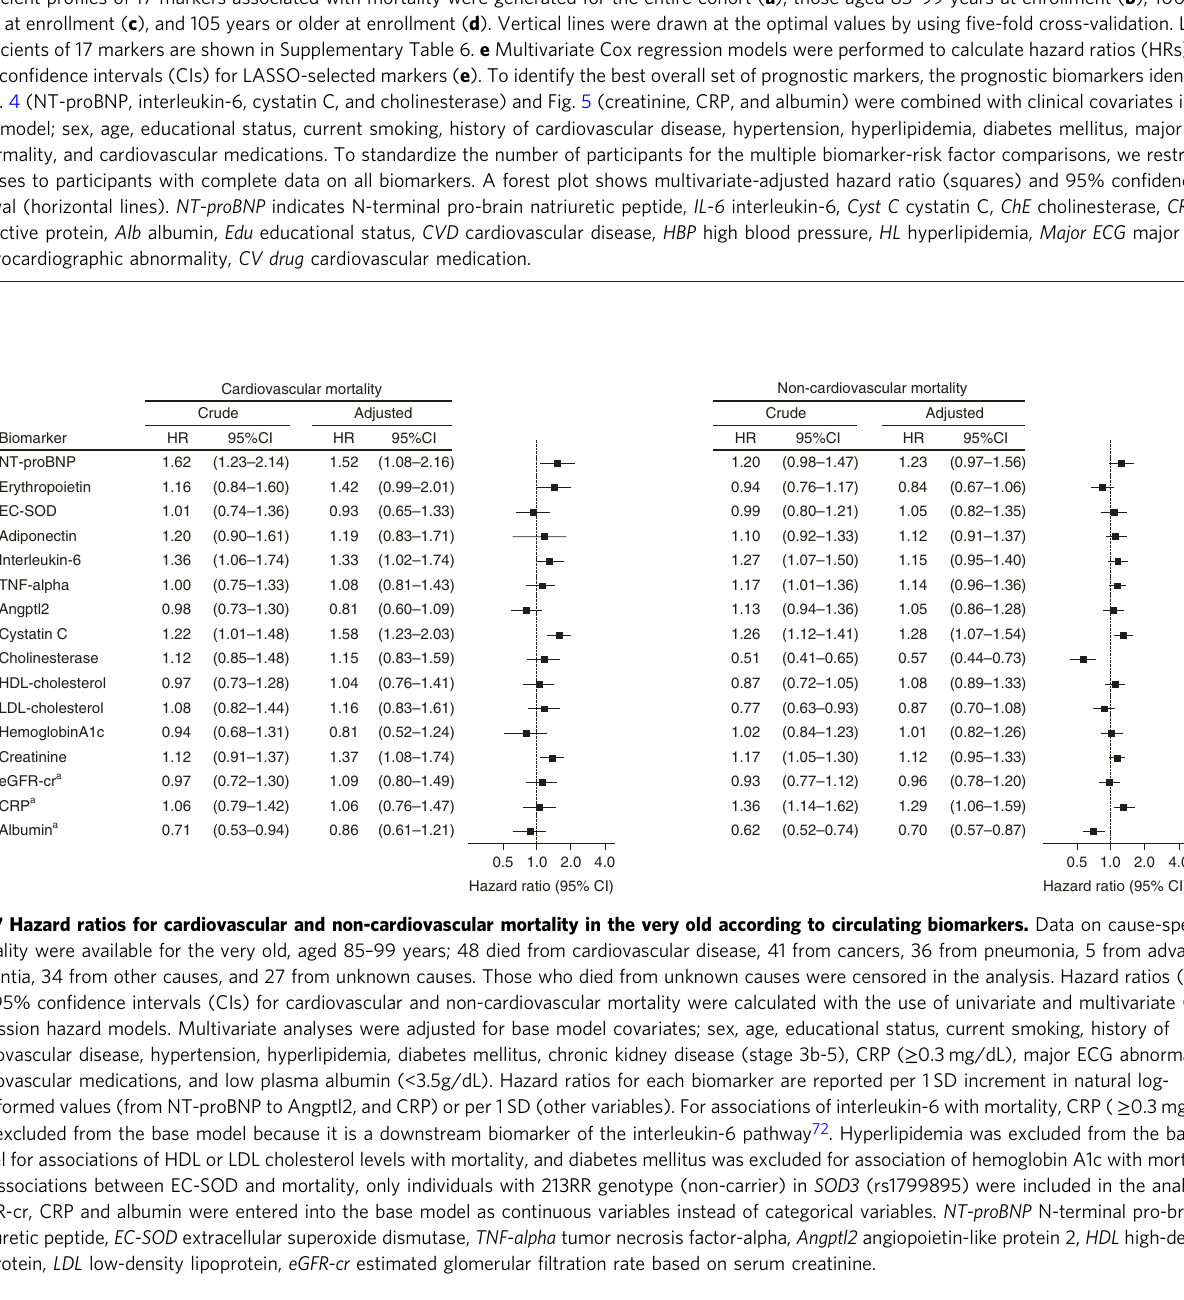
Fig. 6 Selected best set of prognostic markers by LASSO-Cox regression analysis. The least absolute shrinkage and selection operator (LASSO) coef fi cient pro fi les of 17 markers associated with mortality were generated for the entire cohort ( a ), those aged 85 – 99 years at enrollment ( b ), 100 – 104 years at enrollment ( c ), and 105 years or older at enrollment ( d ). Vertical lines were drawn at the optimal values by using fi ve-fold cross-validation. Lasso coef fi cients of 17 markers are shown in Supplementary Table 6. e Multivariate Cox regression models were performed to calculate hazard ratios (HRs) and 95% con fi dence intervals (CIs) for LASSO-selected markers ( e ). To identify the best overall set of prognostic markers, the prognostic biomarkers identi fi ed